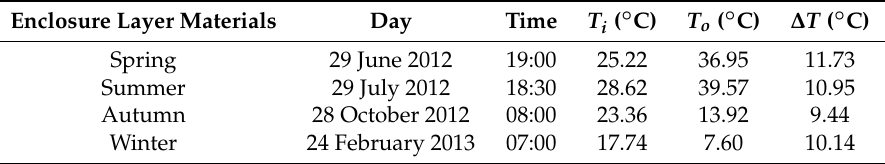
Table 5. Results for T i − T o during the greatest thermal gaps for each climatic